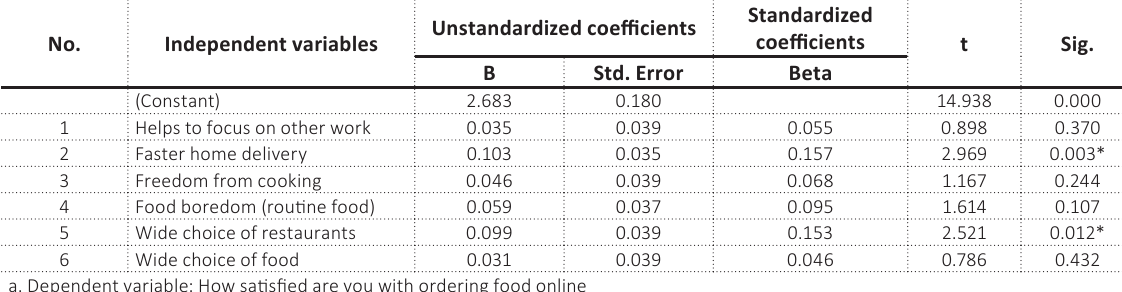
Table 13. Regression analysis of hypothesis H2